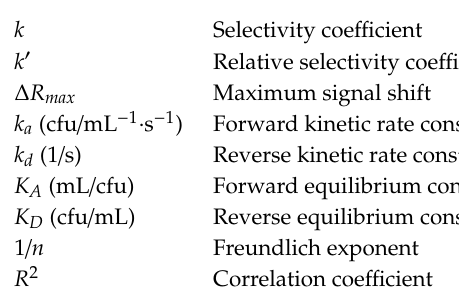
Figure S1: Nanoparticle characterization results: ( a ) SEM; ( b ) AFM and ( c ) TEM. Author Contributions: Y.S. and Ö.E. designed the study and performed the experiments and wrote the manuscript. N.C. and A.D. supervised the study and revised the